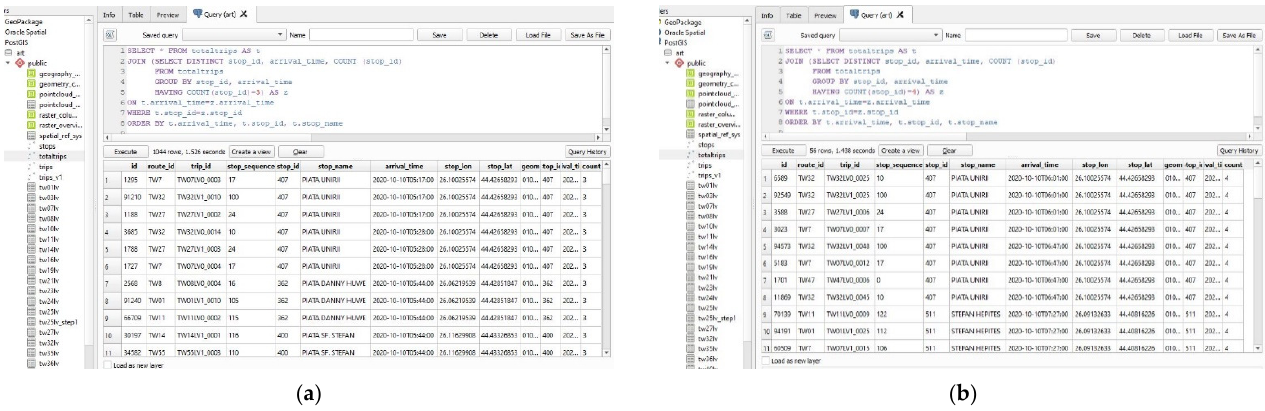
Figure 11. Number of cases of 3 trams ( a ) and 4 trams ( b ) reaching the same station at the same time.